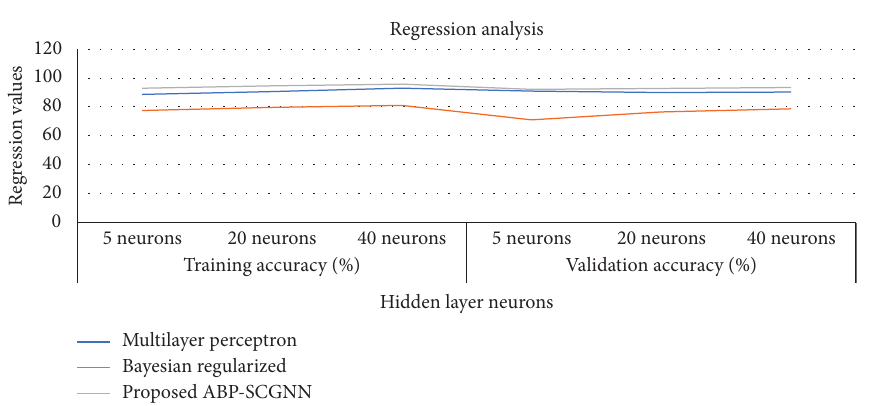
Figure 3: The regression accuracy results of the ABP-SCGNN model at different neurons of hidden